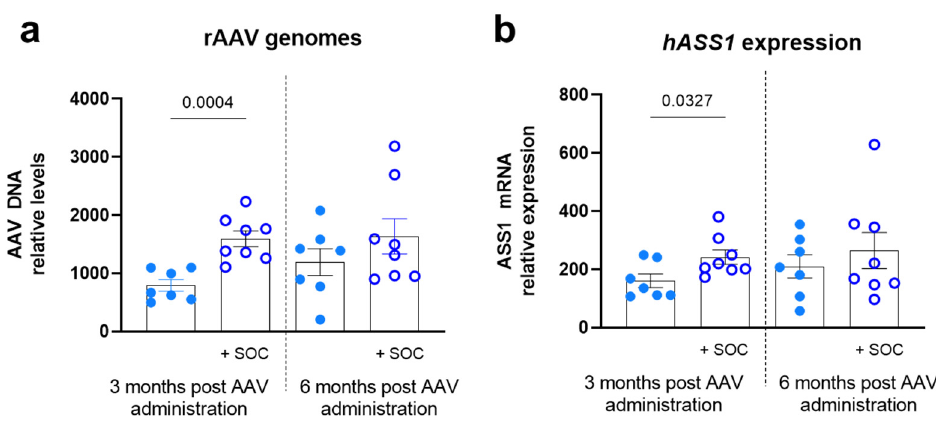
Figure 3. Analysis of liver transduction and transgene expression. Three-week-old Ass1 fold mice were injected with the VTX-804 vector (n = 16), at a dose of 1 × 10 14 vg/kg in combination or not with pharmacological treatment. Three or six months later, mice were sacrificed for quantification of viral genomes ( a ) and transgene expression ( b ) by qPCR and qRT-PCR, respectively. Total DNA values were normalized against Gapdh levels (*10E05) and total mRNA levels against histone (*100). Data were represented as mean ± SEM. Only p < 0.05 values are presented (Student t test).